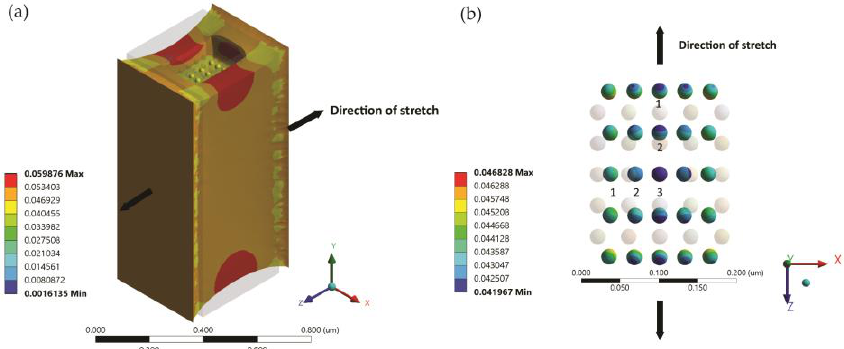
Figure 2. Illustration of the ANSYS simulation. ( a ) Schematic of the simulated device structure, indicating the direction of the applied uniaxial strain. The undeformed model is also shown. A displacement boundary condition of 50 nm was applied in this case. ( b ) Displacement of the nanoisland array under an applied displacement of 50 nm, showing the movement in the x and z directions in relation to the original positions.